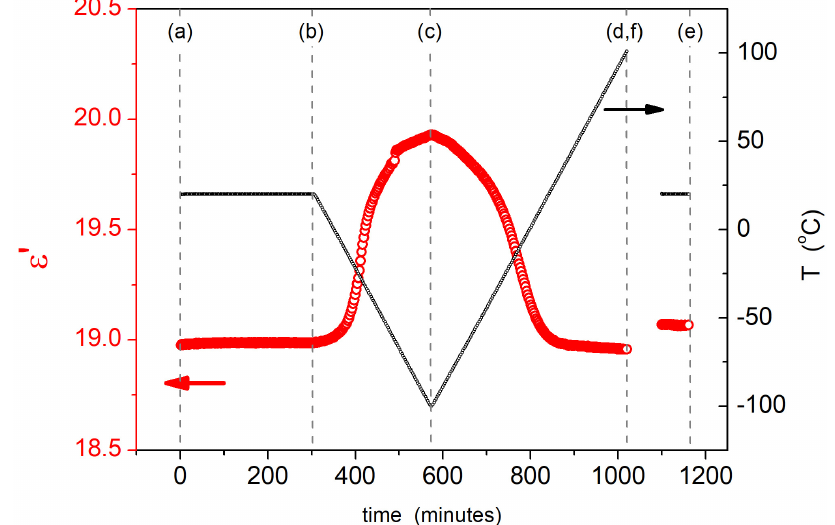
Figure 6. Typical time and temperature dependences of the real part of complex permittivity ε ’ of DDSQ-2SiVi compound, measured at 100 Hz. Letters denote characteristics temperatures: ( a ) 20 °C (pristine sample, before thermal studies); ( b ) 20 °C (after 300 min, at T = 20 °C), ( c ) the minimum temperature at − 100 °C, ( d , f ) maximum temperature at 100 °C and ( e ) 20 °C (after thermal treatment).